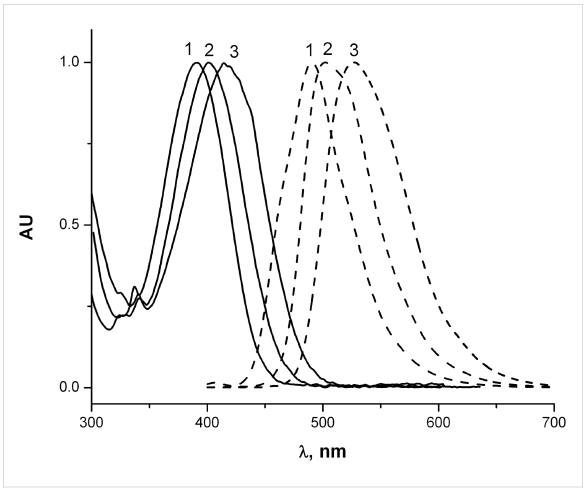
Figure 1: Normalized absorption (solid curves) and fluorescence (dashed curves) spectra of 4 : (1) in cyclohexane; (2) in toluene; and (3) in CH 2 Cl 2 .